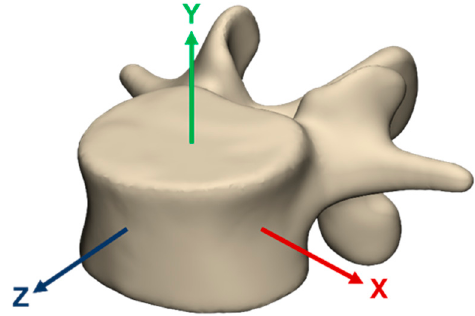
Figure A3. Local coordinate system of a vertebra.